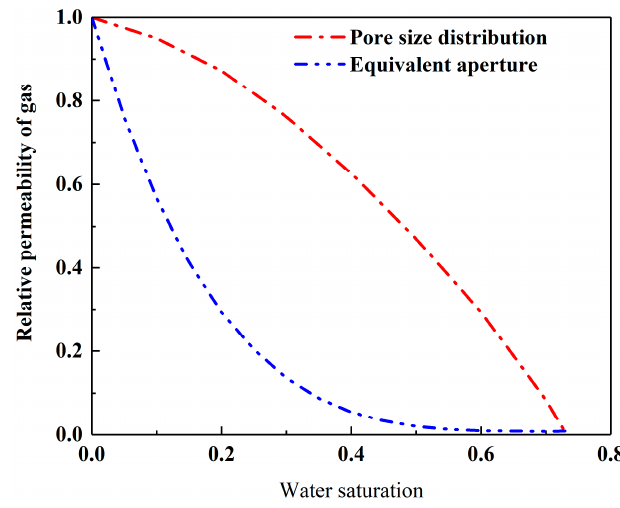
Figure 20. The relative permeability calculated by PSD and equivalent aperture ( p =50 MPa).